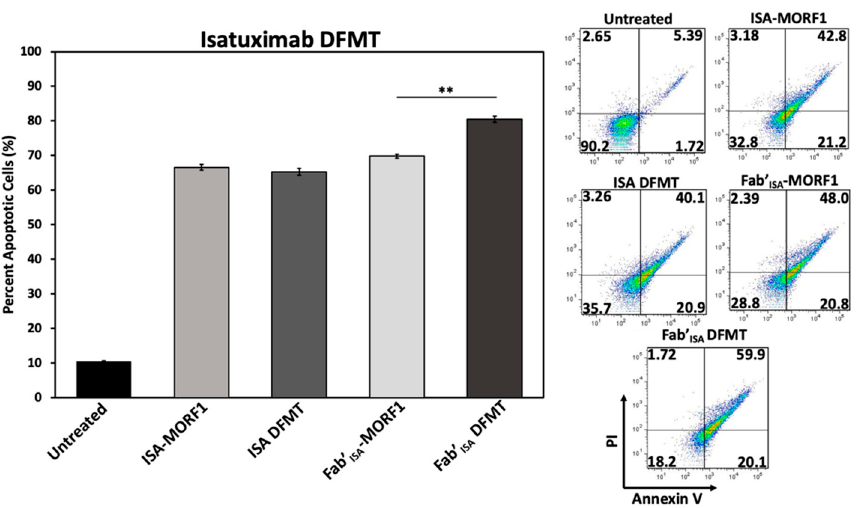
Figure 6. ISA-based DFMT performed on Daudi cells. Apoptosis was measured after ISA DFMT or Fab’ ISA DFMT using Annexin V and Propidium Iodide staining. Flow cytometry was performed to